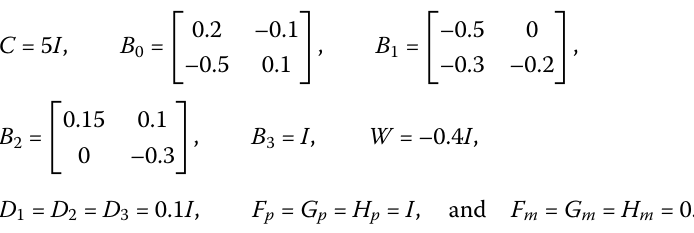
Example 4.5 Consider the neural network (1) with σ 1 = 0.1, σ 2 = 0.5, β 1 = 2, β 2 =